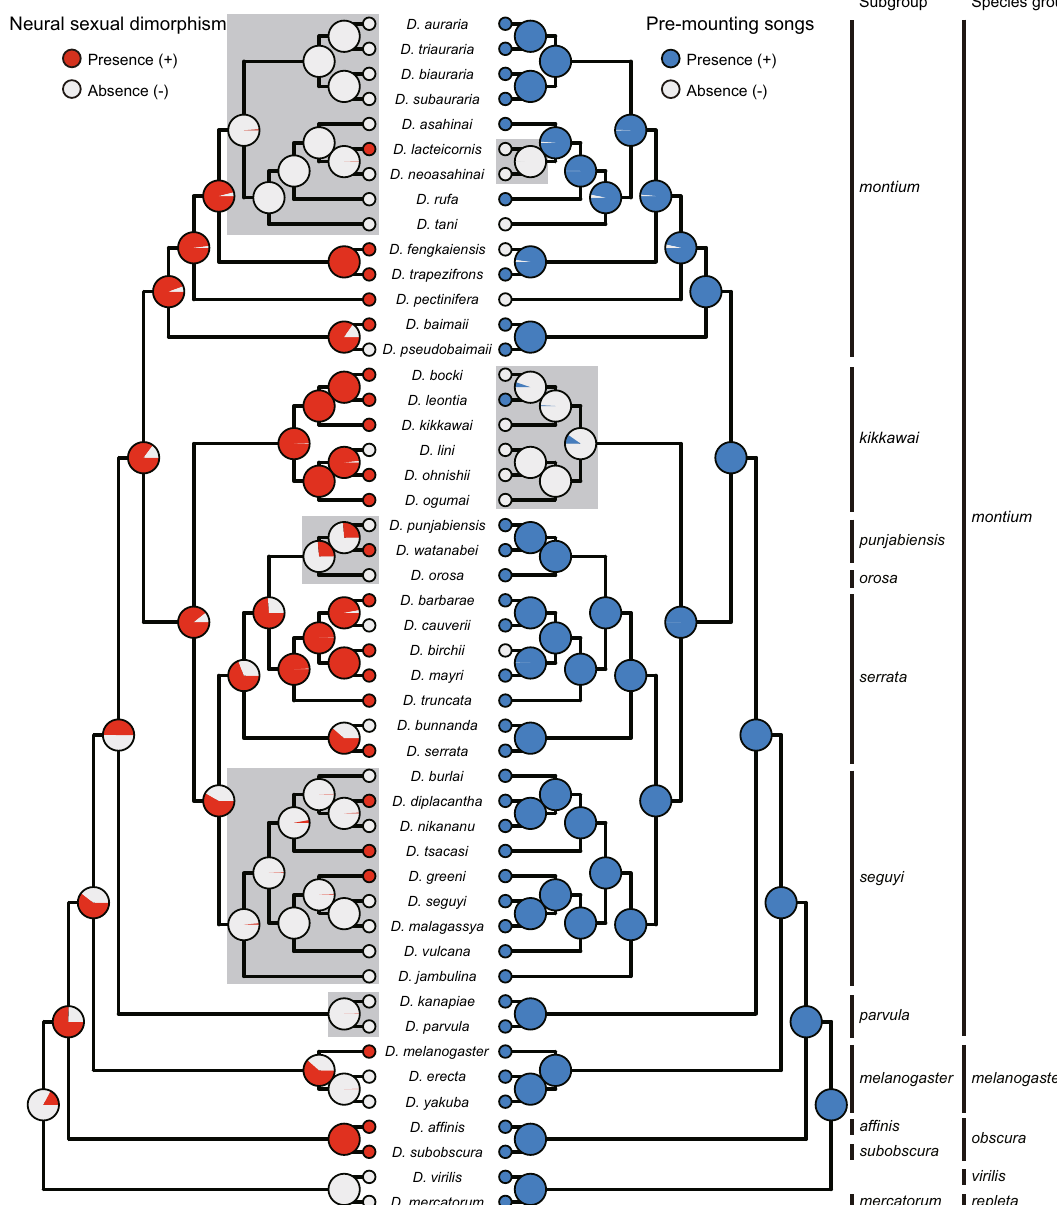
Figure 6. Ancestral reconstruction of the neuromuscular sexual dimorphism in A5 for a Bayesian tree by BBM analysis. The presence or absence of the neuromuscular sexual dimorphism in the A5 segment was determined based on the results shown in Figs. 1 and S3 and Table 1. Pie charts along nodes indicate the probability of ancestral distribution of the neuromuscular sexual dimorphism estimated by BBM analysis (left-hand side panel). It is inferred that the neuromuscular sexual dimorphism was lost at the MRCAs of several lineages indicated by shading. The ancestral distribution of pre-mounting song states (right-hand side panel) is similarly constructed based on our previous observations (summarized in Fig. S5 according to Fig. 3 in Chen et al. 8 ) and our unpublished result. The pre-mounting song was probably lost in the two lineages indicated by